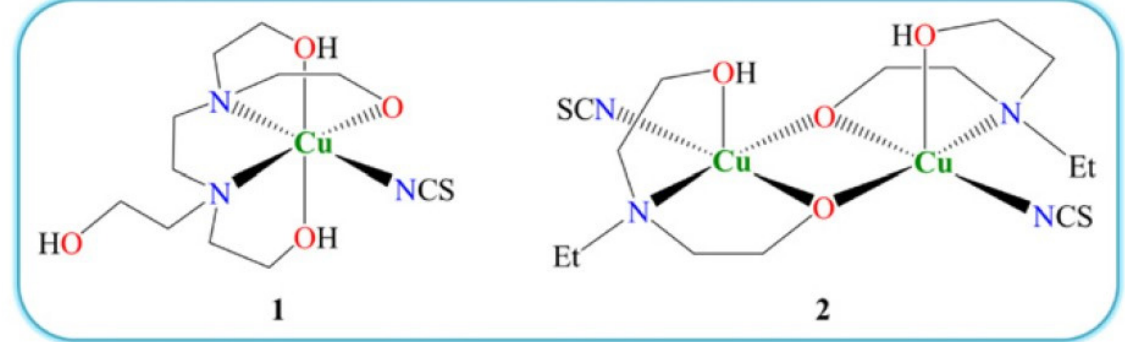
Figure 4. Formulae Complex 5 (left) and 6 (right), which have been used in oxidations with peroxides adapted from Ref. [64], Copyright (2011) with permission of Elsevier.